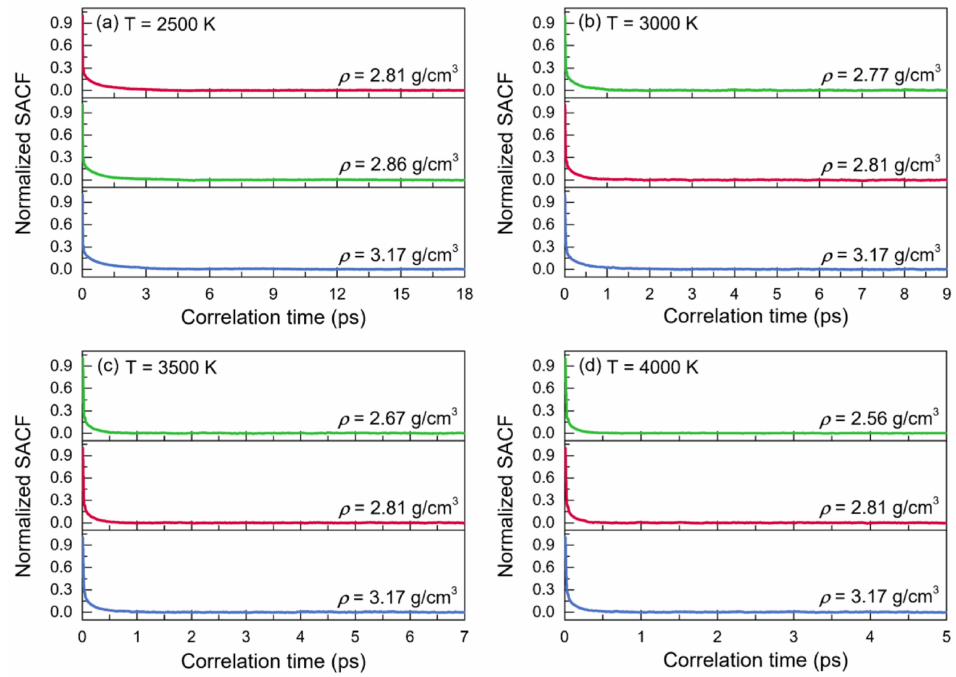
Figure 9. Normalized stress autocorrelation functions (SACFs) for the configurations of liquid alumina with three different densities at ( a ) 2500 K, ( b ) 3000 K, ( c ) 3500 K, and ( d ) 4000 K,